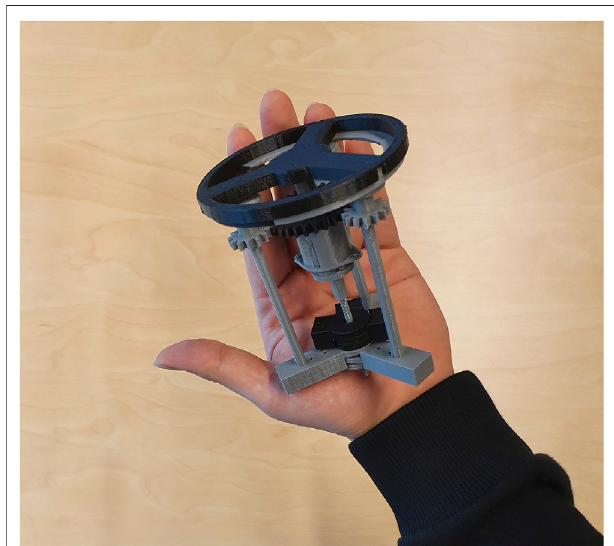
FIGURE 7 | A proposed control unit sizing and learning polylactic acid (PLA) prototype. This control unit was prototyped to show preliminary feasibility and identify learning points in preparation for more extensive metal prototyping. It is the complete triplicate prototype for the single subunit (one third) mechanism shown in Supplementary Video S3 . Each subunit controlsthreerodsand thethree subunitsareaddedtogetherinawheel-and- spoke fashion with 120 degrees between each subunit. The complete control unit was designed to control up to nine rods in a narrow-diameter (2 cm) keyhole surgical instrument such as the one detailed in our preliminary brief research report (Roche et al., 2021b).